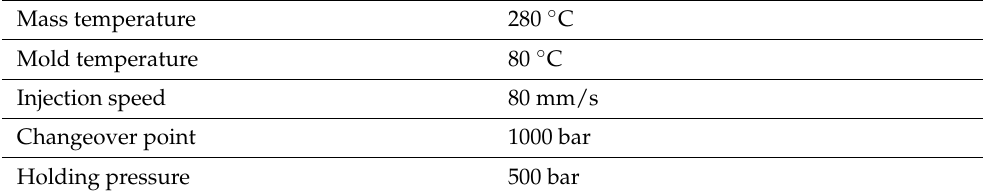
Table 2. Processing parameters of injection molding to fabricate test samples (PA12 with 55 vol.-% SrFeO). Mass temperature Mold temperature Injection speed Changeover point Holding pressure 500